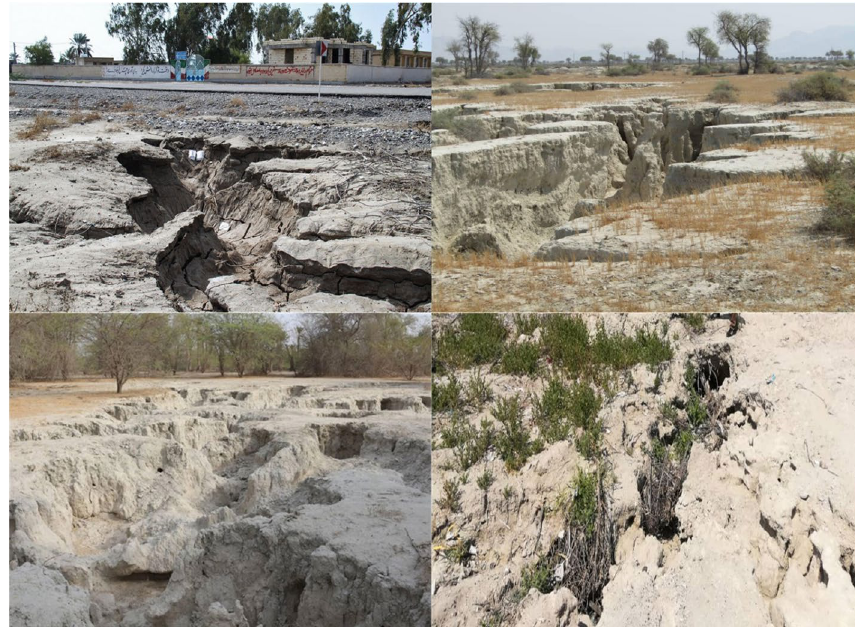
Figure 2. Photographs showing the land surface in the study